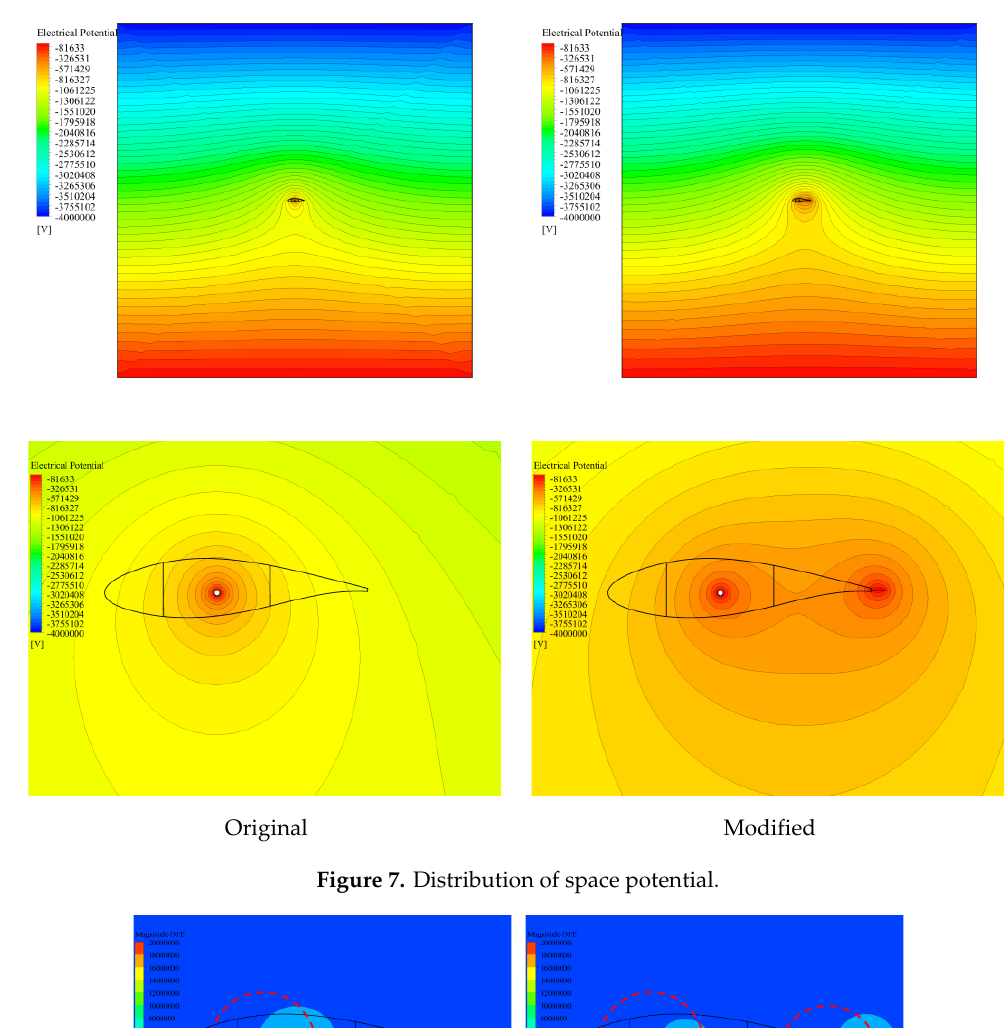
Figure 7. Distribution of space potential.